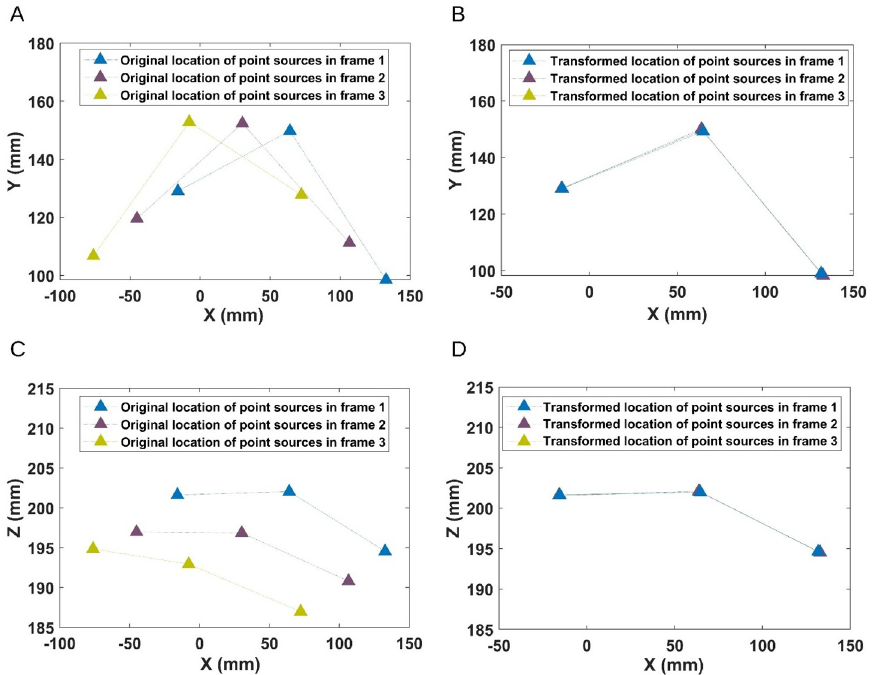
Fig 4. Comparison of original point source positions with transformed locations. Point source locations in each different frame in the axial plane (top row) (A) before and (B) after application of the transformation, and in the coronal plane (bottom row) (C) before and (D) after application of the transformation.